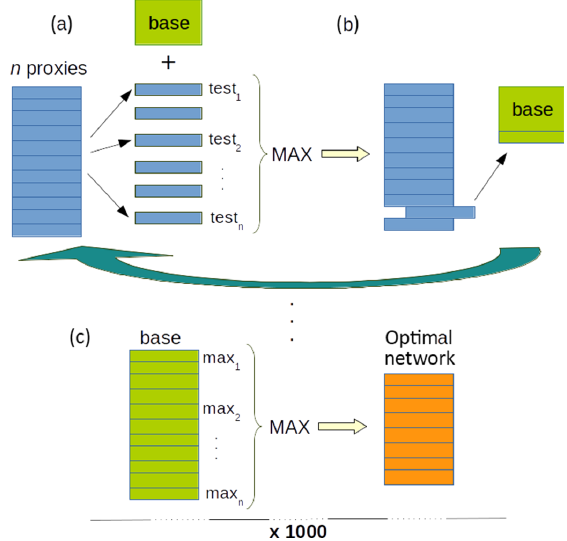
Figure 1. Network creation process diagram. Overview of the net- work creation process. (a) A new network is created from the base network ( base ) plus each pseudo-proxy individually and is tested for its reconstructive power. This results in n test scores; (b) the highest score (max n ) is selected and the associated proxy is moved from the test proxies to base . This is repeated until all test prox- ies are incorporated into base . (c) The optimal network is selected by cutting base where max n was highest. The entire process is re- peated 1000 times, with new noise realisations being added to the pseudo-proxies at the start of each